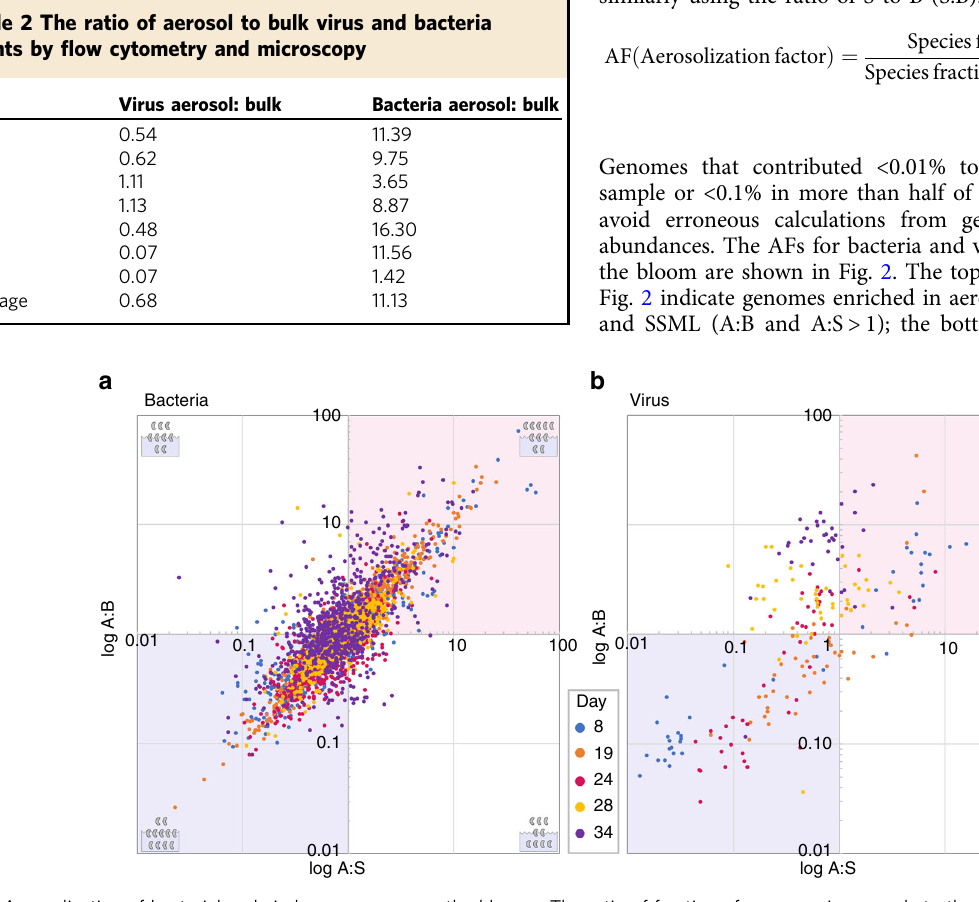
Fig. 2 Aerosolization of bacterial and viral genomes across the blooms. The ratio of fraction of genomes in aerosols to the fraction in bulk (A:B) plotted against ratio of fraction of genomes in aerosols to those in sea surface microlayer (A:S) is shown for bacteria ( a ), and viruses ( b ), over the course of the experiment. The upper right quadrants (red) of a and b indicate genomes enriched in aerosol relative to both bulk and SSML (A:B and A:S > 1); the lower left quadrants (blue) indicates genomes that are primarily waterborne (A:B and A:S < 1). The upper left quadrants indicates genomes enriched relative to bulk but not SSML (A:B > 1, A:S < 1), and the lower right indicates species enriched in aerosol relative to the surface but not bulk (A:B < 1, A:S > 1). The data sets represent a 700 bacterial genomes and b 46 viral genomes identi fi ed by read-based taxonomic assignments fi ltered of genomes below abundance thresholds. Graphics in the corners various quadrants in a show examples of expected species ratios in indicated portion of graph